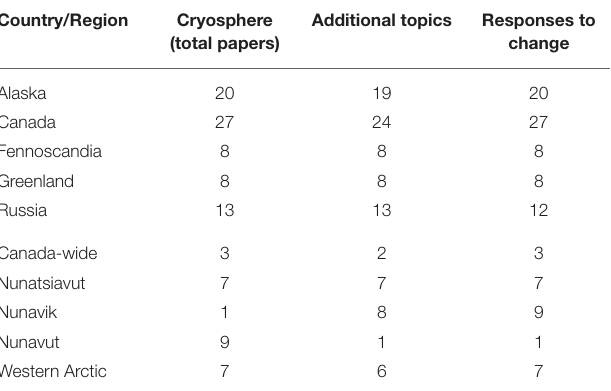
TABLE 1 | Number of papers in the sample, by country and by region of Canada, showing coverage of cryosphere (equal to the total number of papers), additional topics, and responses to